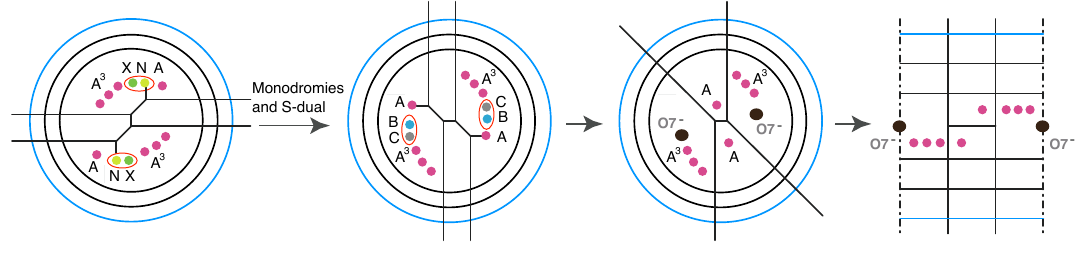
Figure 46 . A T-dual version of 6d [1 A ; 8] (cid:0) SU(4) (cid:0) SU(4) (cid:0) SU(4) (cid:0) [4] yielding 5d [3] (cid:0) Sp(3) (cid:0) (SU(7) [2]) Sp(3) [3] implementing S-dual invariant 7-brane (cid:0) (cid:0) (cid:0)